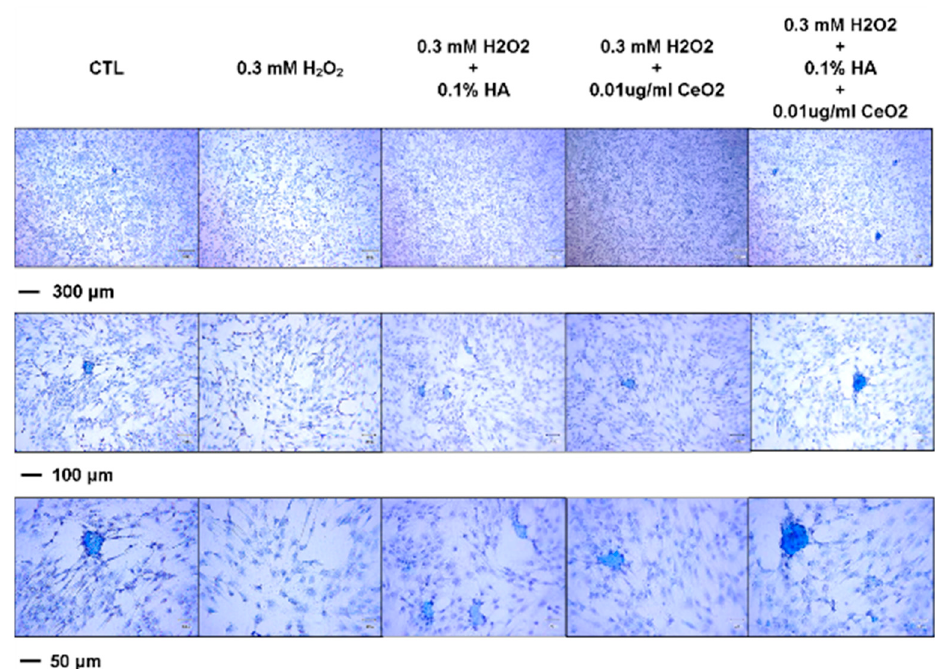
Figure 8. Effect of CeO 2 nanoparticles-loaded hyaluronic acid treatment glycosaminoglycan (GAG) synthesis. Consistent with the gene expression patterns of ACAN, COL1A1, and COL2A1, H 2 O 2 treatment can reduce the production of sulfated proteoglycan as determined by alcian blue staining. In the H 2 O 2 -treated samples, cellularity was relatively sparse with destructed cell membrane; whereas with the treatment of HA, CeO 2 can reverse the H 2 O 2 -treatment effects. The accumulation of sulfated proteoglycan was most obvious when the cells were pretreated with both HA and CeO 2